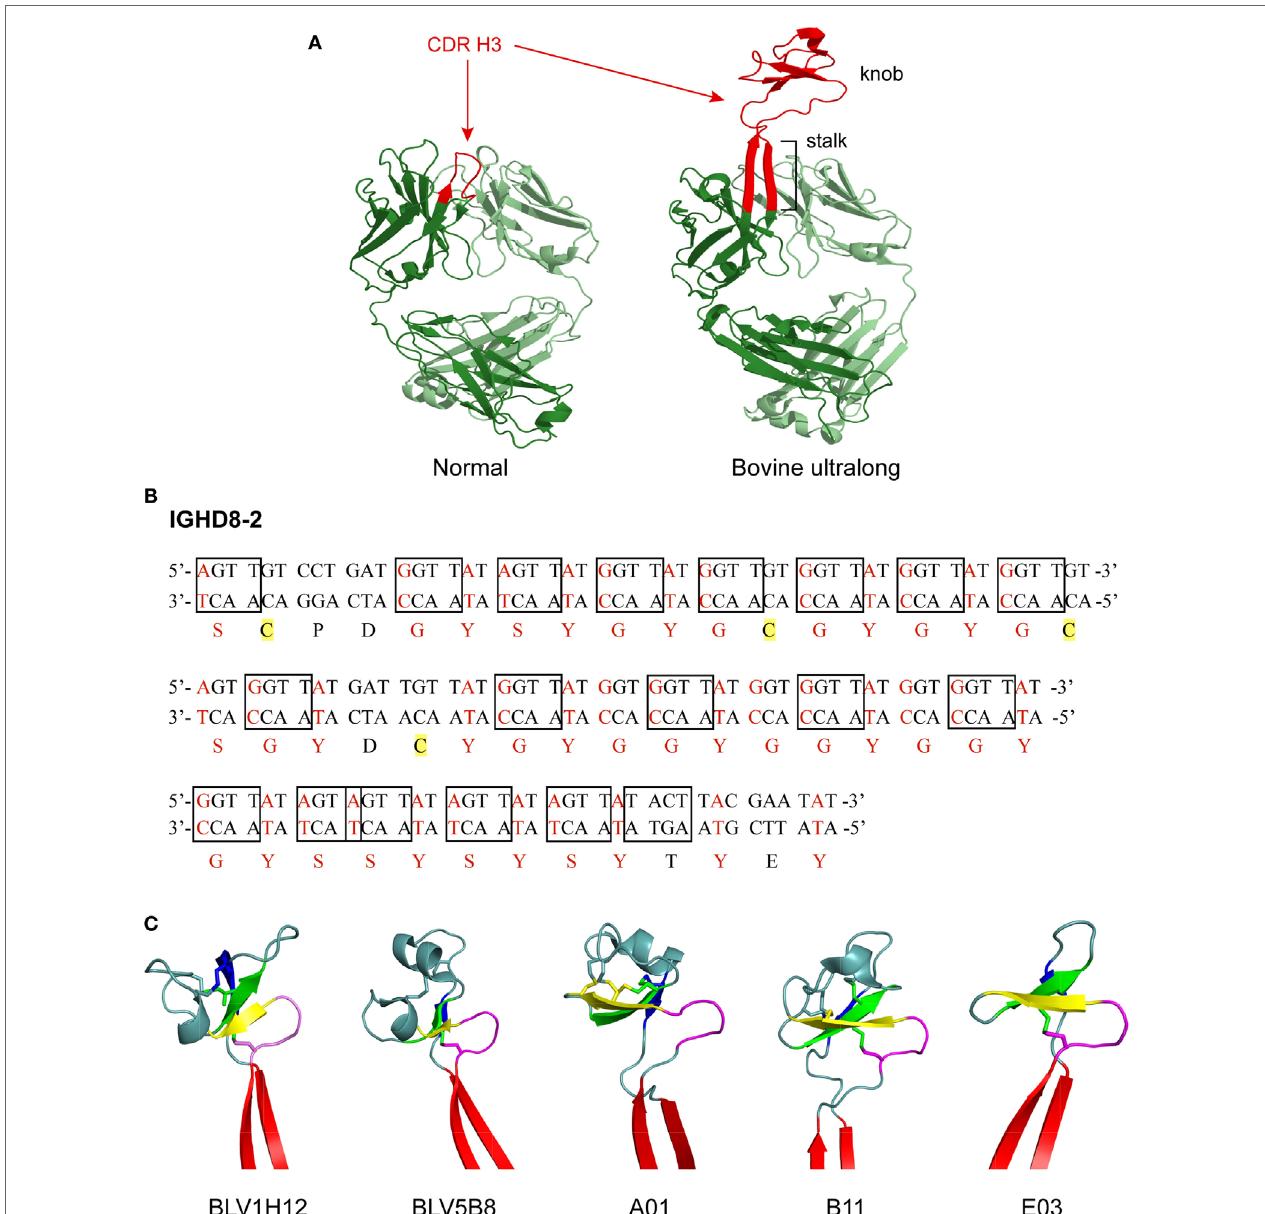
FiGUre 1 | Structure and genetics of ultralong complementarity determining region (CDR) H3 cow antibodies. (A) Comparison of normal and ultralong CDR H3 antibody fab fragments. Crystal structures of Yvo, a typical human antibody (left), and B11, an ultralong bovine antibody (right). The CDR H3 of each antibody is highlighted in red. Heavy chains are colored dark green and light chains are colored pale green. Note the two long β strands that make up the stalk of the bovine ultralong CDR H3 and the disulfide-bonded knob domain at the top. PDB IDs of these two fabs are Yvo: 2AGJ; B11: 5IHU. (B) Sequence and potential diversity of the ultralong D H region. Potential AID-induced somatic hypermutation hotspot motifs (“RGYW”/“WRCY”) in bovine germline IGHD8-2 are boxed on both strands of the DNA sequence. Nucleotides within a codon that can be mutated to a cysteine-encoding codon with just a single nucleotide change are colored red, and corresponding amino acids encoded by these codons are also colored red. Four cysteine residues encoded by the germline IGHD8-2 are highlighted yellow. (c) “Stalk and knob” structures of the ultralong CDR H3s. The β -ribbon stalk is colored red, the type I β -turn is colored magenta, and the three antiparallel β strands are colored yellow, green and blue, respectively. Disulfide bonds formed within the knob region are represented as sticks. PDB IDs of these five fabs are BLV1H12: 4K3D; BLV5B8: 4K3E; A01: 5ILT; B11: 5IHU; and 5IJV.